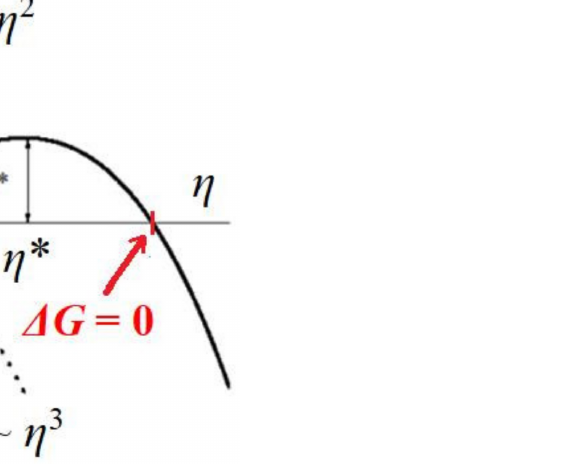
(cid:16) (cid:17) c is the driving c e